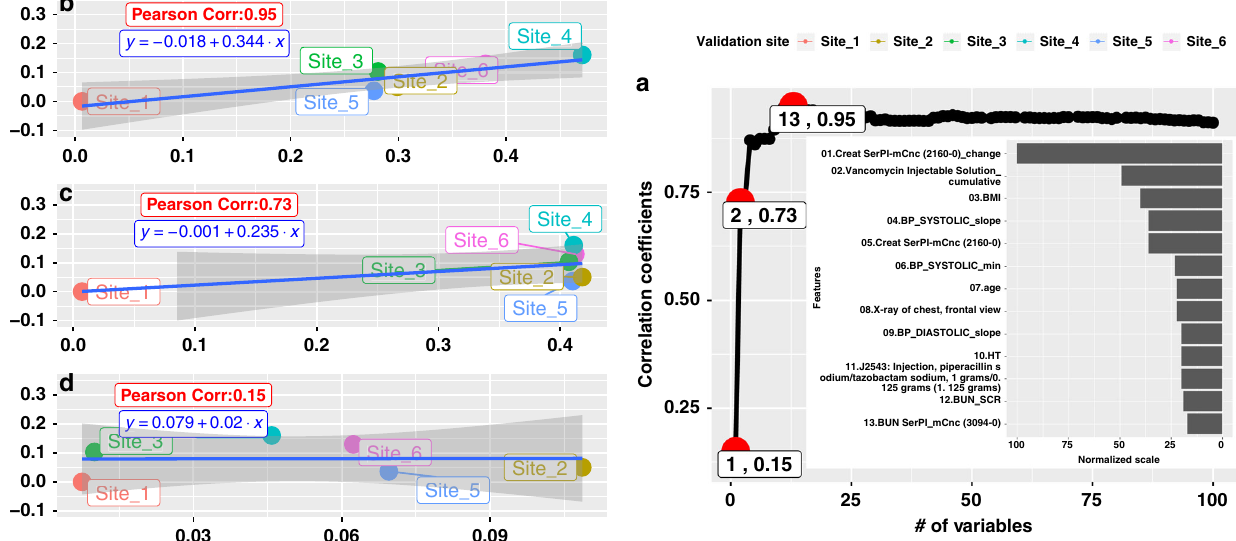
Fig. 5 Correlation Between adjMMD and Prediction Performance (AUC) for predicting moderate-to-severe AKI in 48 h). It shows full details on how adjMMD can be used to infer the prediction performance drop. Panel a on the right illustrates the Pearson Correlation Coef fi cient between adjMMD value and AUC drop as a function of the number of variables included (e.g., the fi rst red circle with a label of “ 1, 0.15 ” suggests that if only the most important variable is considered, the correlation between adjMMD and AUC drop is 0.15). b , c , d on the left demonstrate the simple regression lines between adjMMD and AUC drop with 95% con fi dence band shaded. Take d as an example, when only the most important variables ( Create SerPL-mCnc (2160-0) change , or SCr change ) are considered, the adjMMD is barely predictive of Δ AUC. The more features are included in the adjMMD measure, the better it is at anticipating AUROC deterioration. Experimental results suggest that when top 13 important features are included for predicting moderate-to-severe AKI in 48 h, the strength of association between adjMMD and Δ AUC reaches an optimal value of 0.95 measured by Pearson correlation coef fi